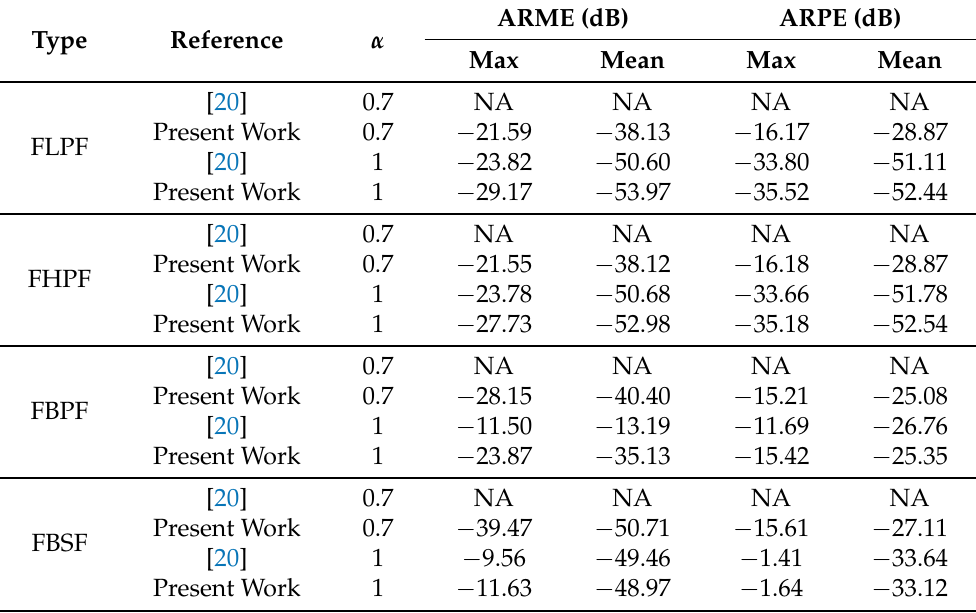
Table 11. Error metrics comparison of the proposed filters with the reported literature for β = 0.3 (NA: Not